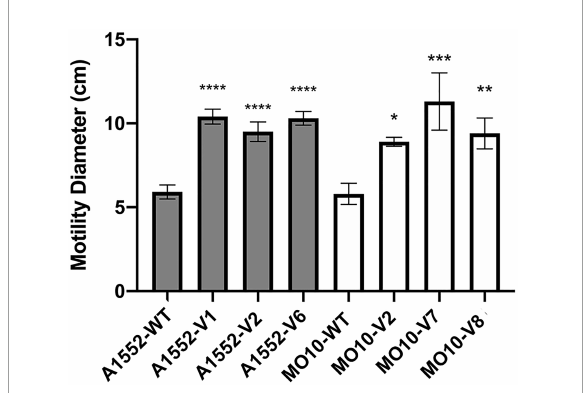
FIGURE3 Variants of A1552 and MO10 present increased motility in the presence of PmB. Motility assay on soft agar supplemented with PmB after 48 h. Data are represented as mean ± SD of at least 3 independent experiments. Statistical significance between the variants’ motility diameter and their respective WT stains was tested by Dunnett’s one-way ANOVA. (* p < 0.05; ** p < 0.01; *** p < 0.001; **** p <